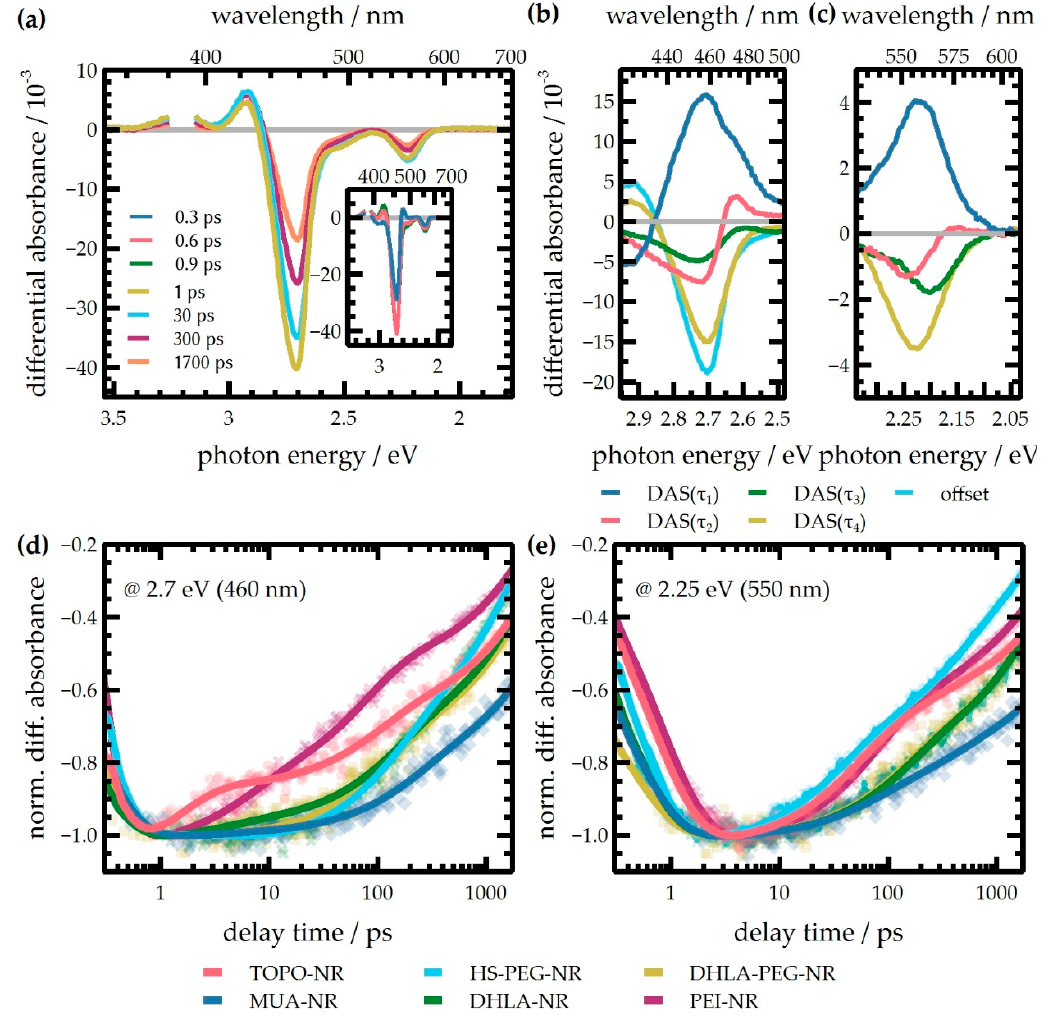
Figure 4. Transient absorption spectroscopy on the investigated structures recorded upon 390 nm excitation. ( a ) Transient spectra of TOPO-NR recorded at the indicated delay times. ( b ) and ( c ) Decay Associated spectra obtained via a global fit for TOPO-NR. The spectral regions 2.48–2.95 eV and 1.97–2.34 eV were fitted separately from each other. The data for all other ligands is displayed in the SI. ( d ) and ( e ) Kinetic traces at 2.70 eV (460 nm) and 2.25 eV (570 nm), respectively, recorded for the different samples. Kinetic traces were normalized to -1 at the minimum of the fit function (solid line), while recorded data points are shown as semi-transparent points.